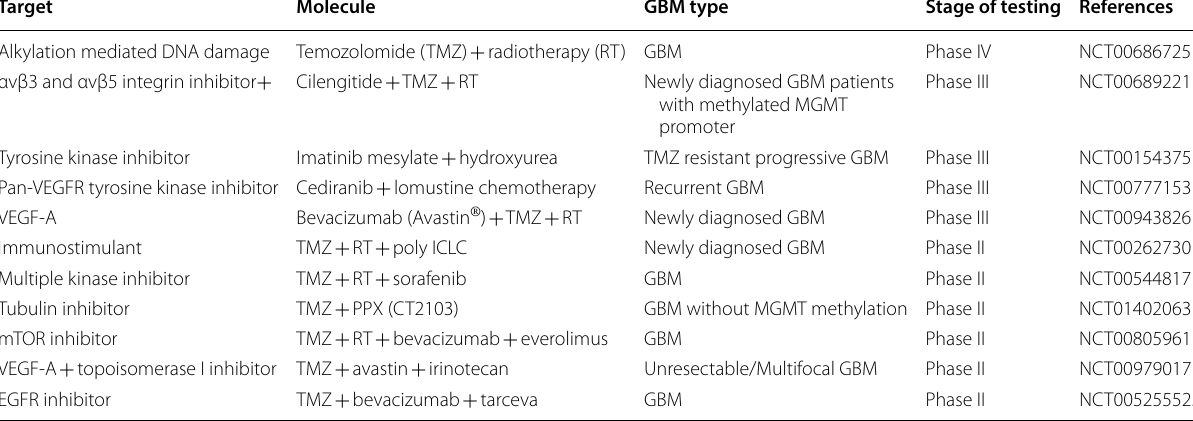
Table 3 Combination therapy in clinical trials for treatment of Glioblastoma multiforme Target